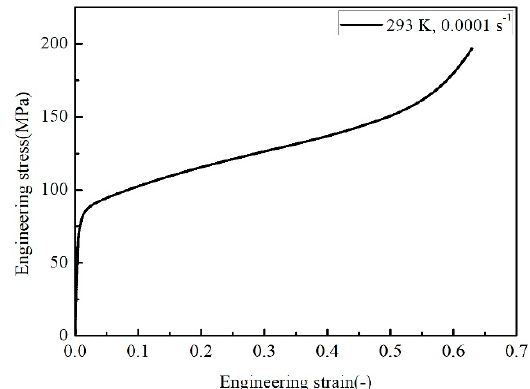
Figure 3. Engineering stress-strain curve at the reference condition.